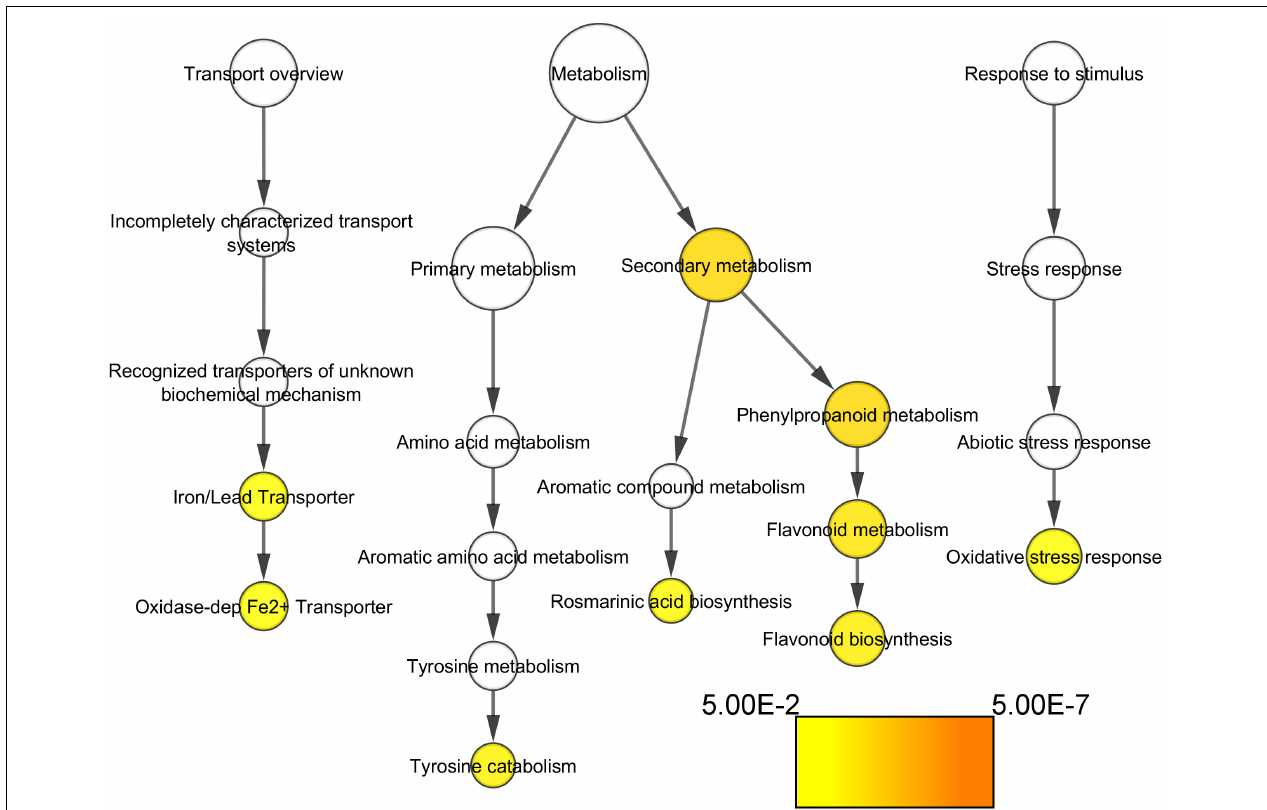
FIGURE 6 | Functional categories of the genes significantly over-represented at E-L 18–19 in VP11 vs. compact clones (adj. p -value < 0.05). Colors are function of significance. White, not significant.